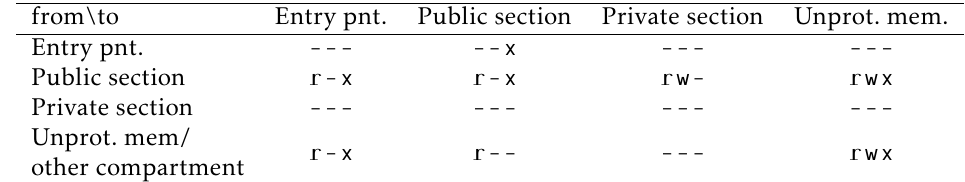
Table 1. The memory access control model enforces, for example, that a compartment’s private section ( 4 th column) can only be read-write accessed from the public section of the same compartment ( 3 rd row)